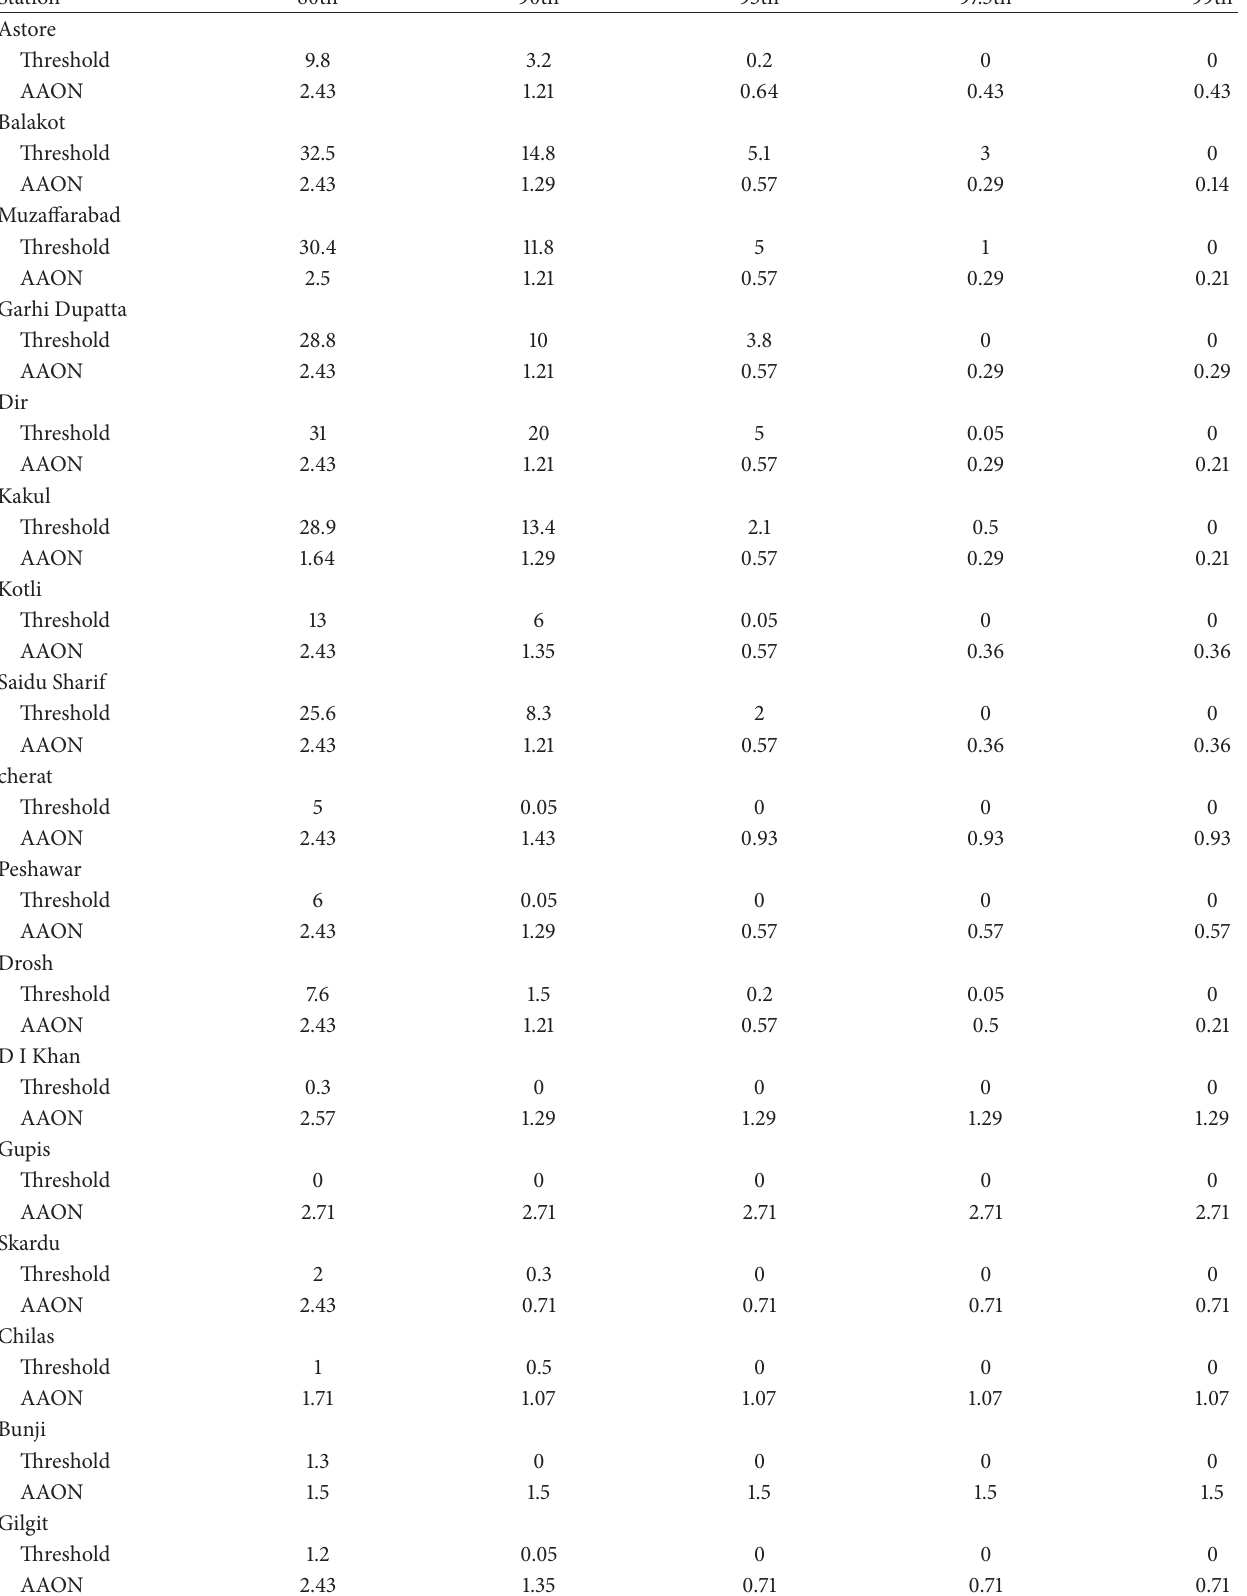
Table 2: Precipitation threshold selection in GPA distribution for 17